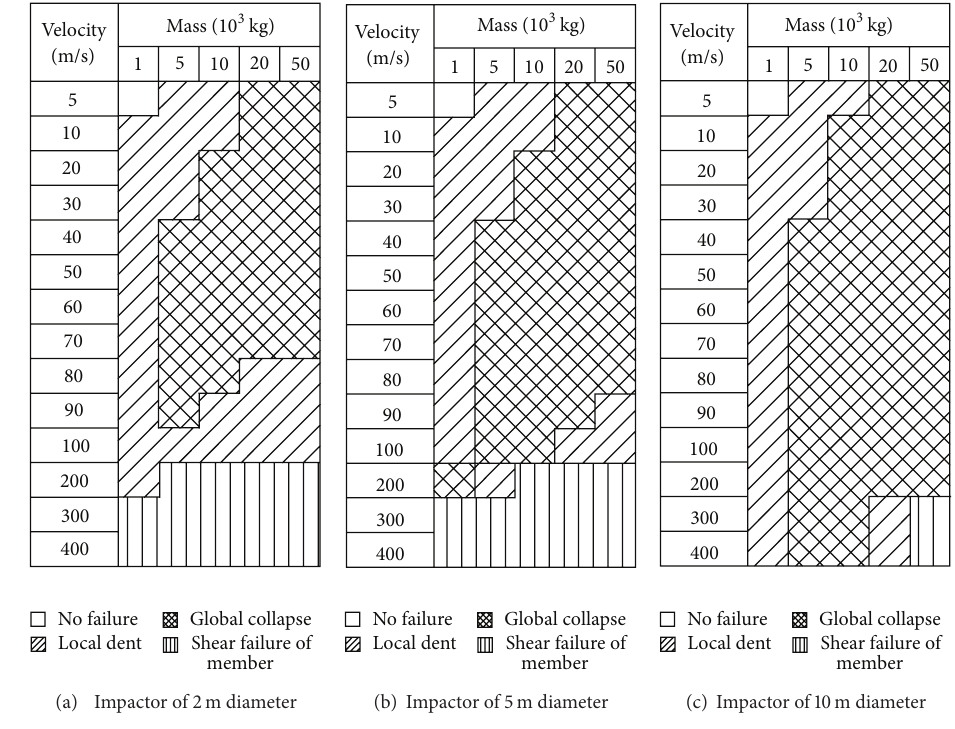
Figure 4: Damage modes of the impact events with the roof load of 120kg/m 2